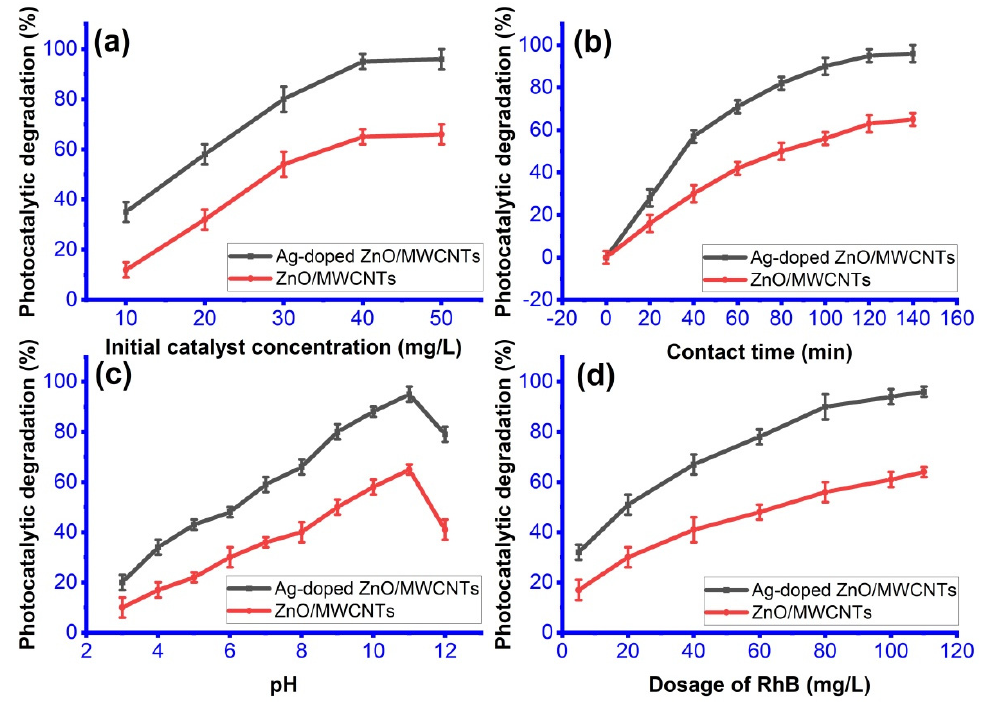
Figure 6. Effect of ( a ) initial catalyst concentration, ( b ) contact time, ( c ) pH, and ( d ) dosage amount of RhB on the removal of RhB.